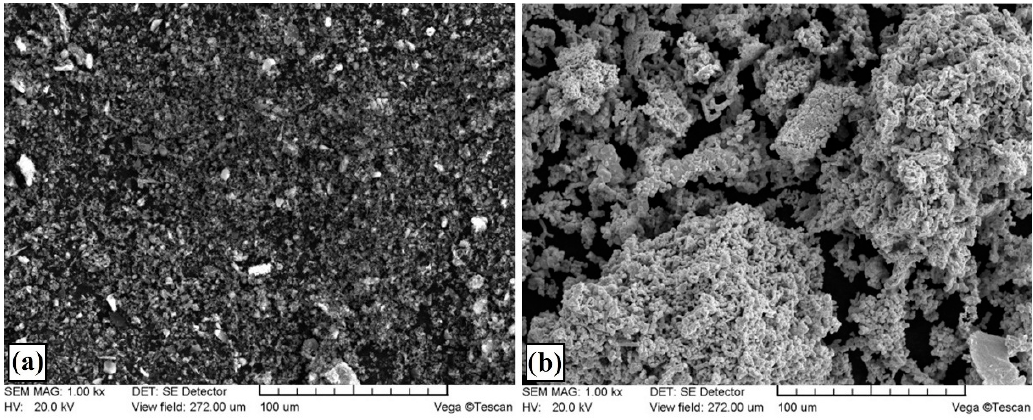
Figure 1. Powder morphologies of boron ( a ) and molybdenum ( b ).